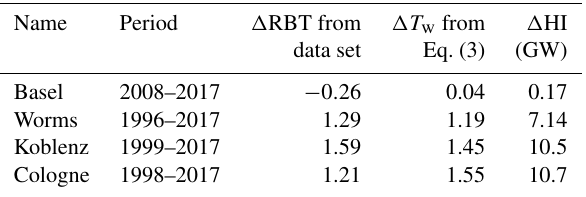
Table 6. Change in RBT (column three) in the time period given in column two. The start of the period indicates the maximum HI of NPPs at the respective monitoring station. The calculated (cid:49)T w (col- umn four) and the change in HI by nuclear power plants (column five) are also provided. The calculations were done using Eq. (3). Note: GW – gigawatt.